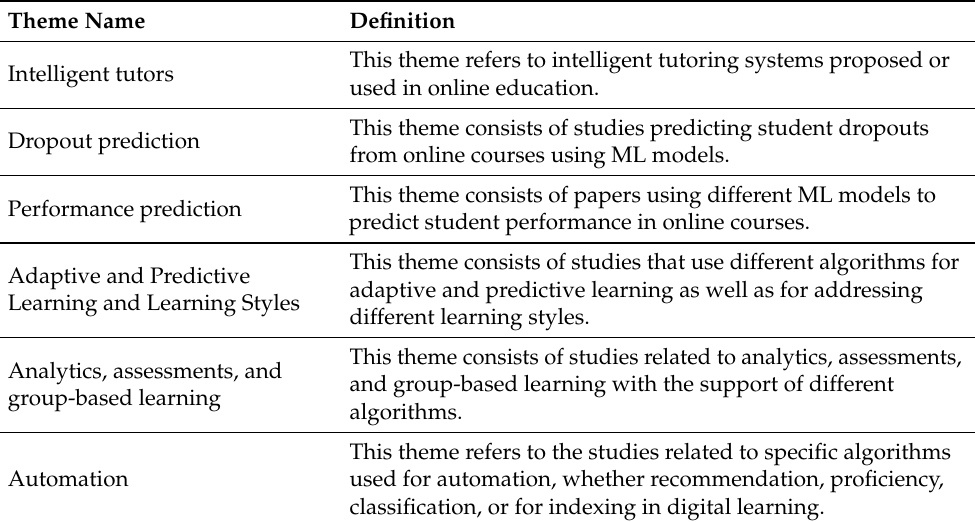
Table 4. Definition of identified themes from thematic